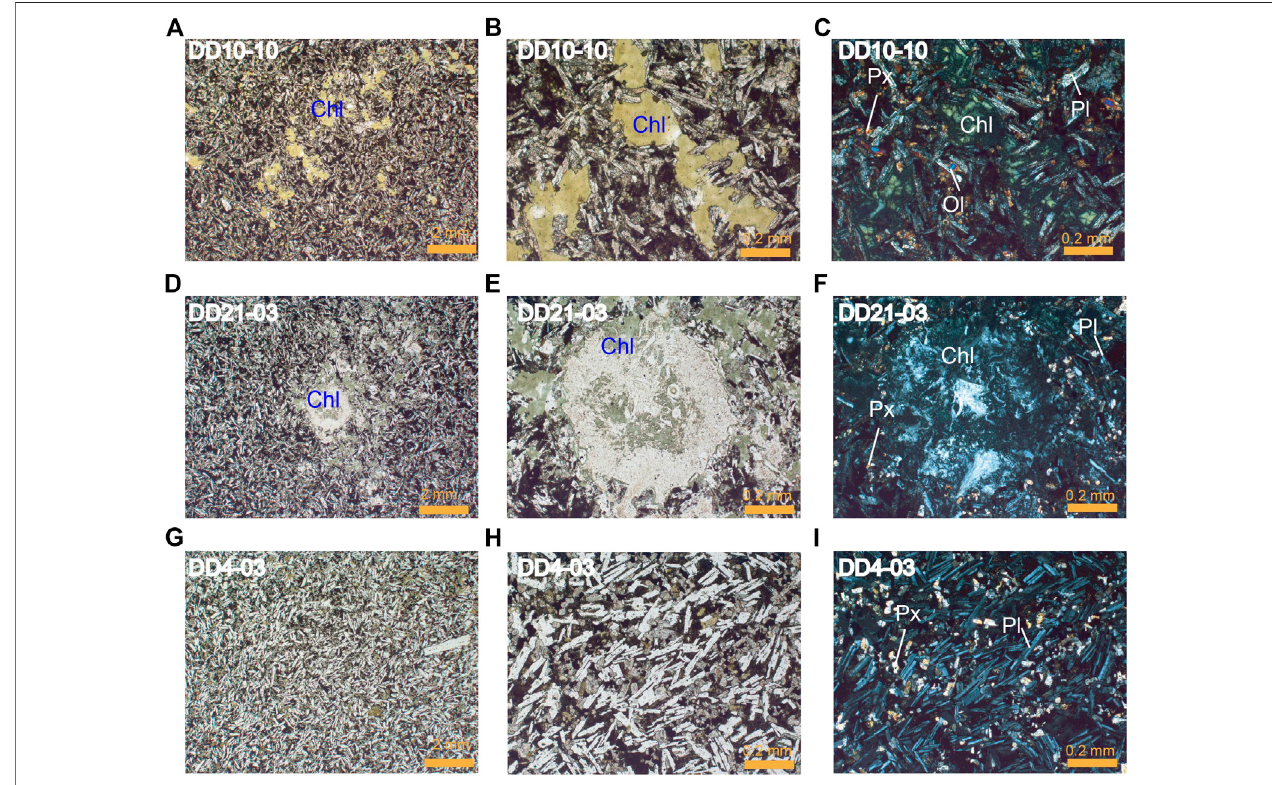
FIGURE8| MicrophotographsfrombasalticsampleDD10-10fromunitIV (A – C) ;sampleDD21-03fromunitIII (D – F) inthisstudyand (G – I) sampleDD4-03which carries a primary remanence (G F I) are in cross-polarized light and the others in plane-polarized light.